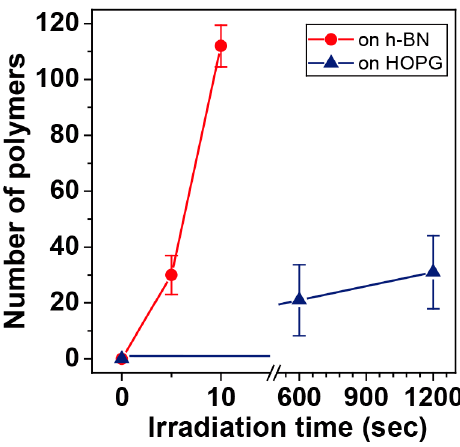
Figure 5. Number of polymers in a 500 × 500 nm 2 area as a function of irradiation time for the photo- polymerization of 10,12-nonacosadiynoic acid on HOPG and h-BN. The lines are guides for the eye.